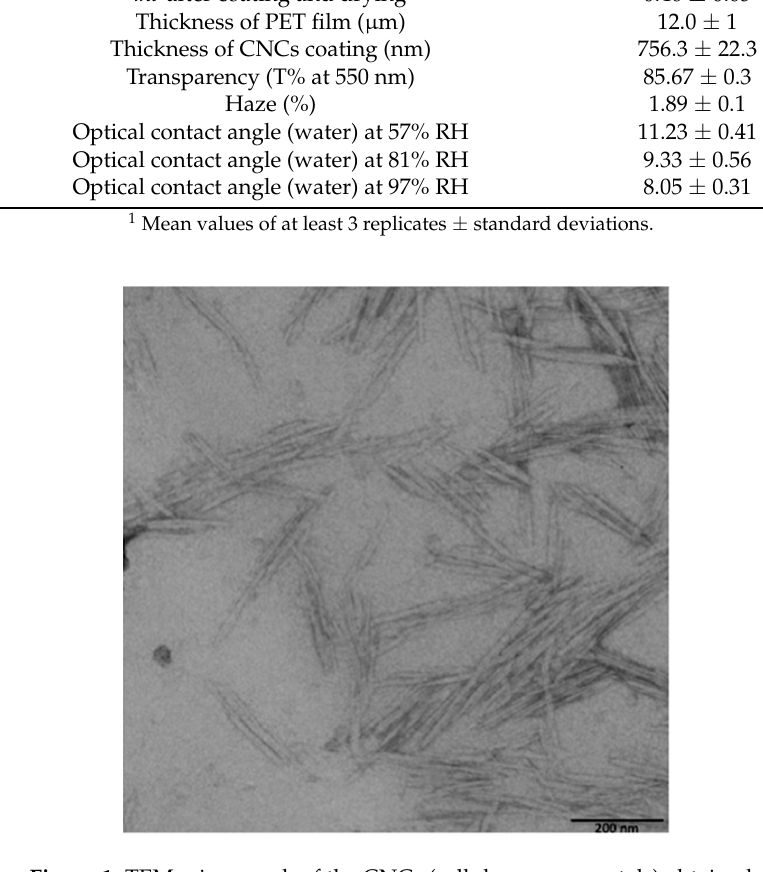
Figure 1. TEM micrograph of the CNCs (cellulose nanocrystals) obtained.